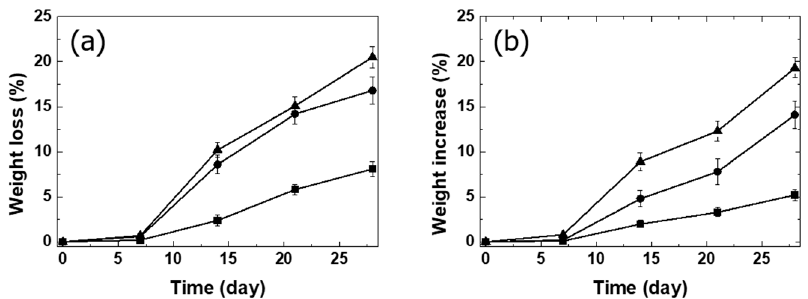
Figure 4. ( a ) Weight loss by phosphate buffer saline (PBS) and ( b ) weight increase by simulated body fluid (SBF) solution of the composites: ■ PLA/PGA fiber30; ● PLA/PGA fiber30/HA10; ▲ PLA/PGA fiber30/HA-g-PLA(m)10.